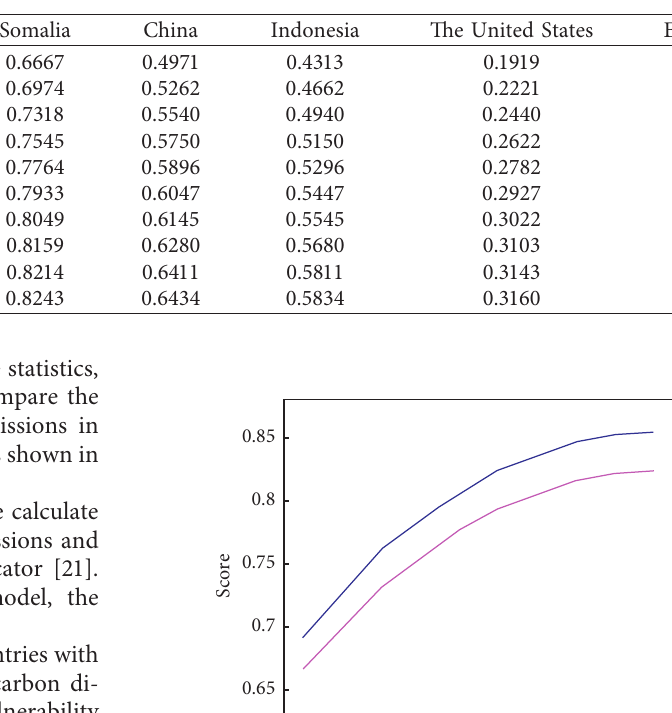
Table 10: Score chart.